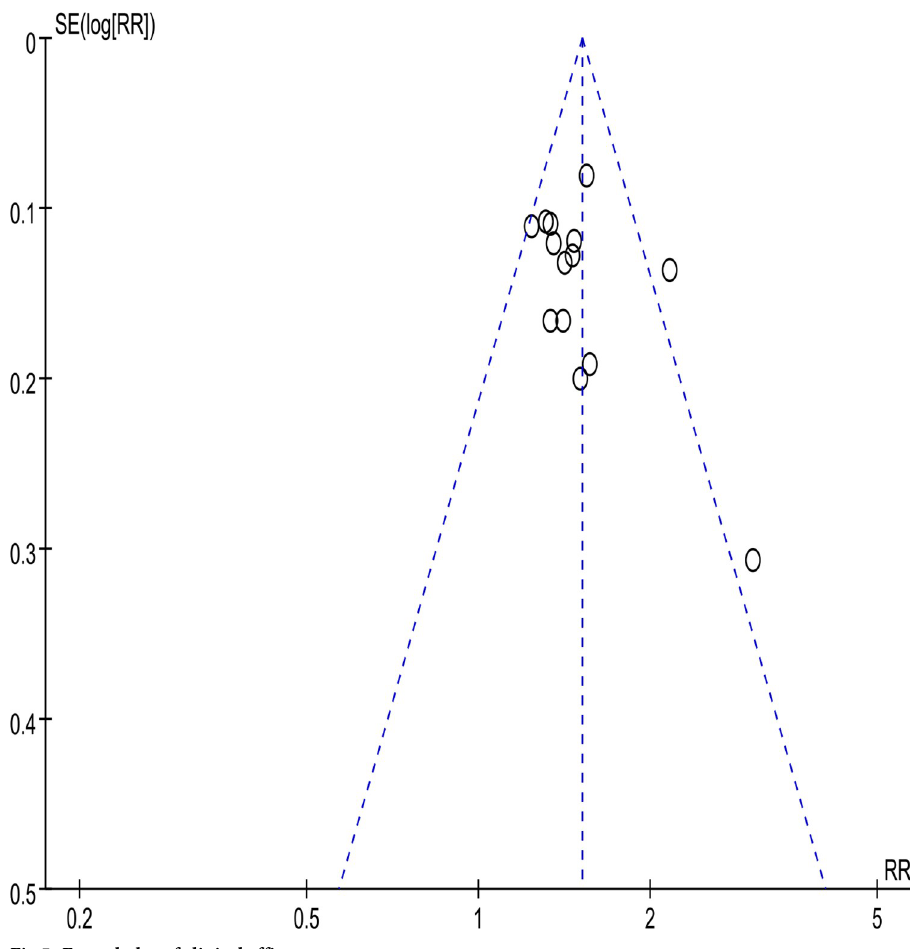
Fig 5. Funnel plot of clinical